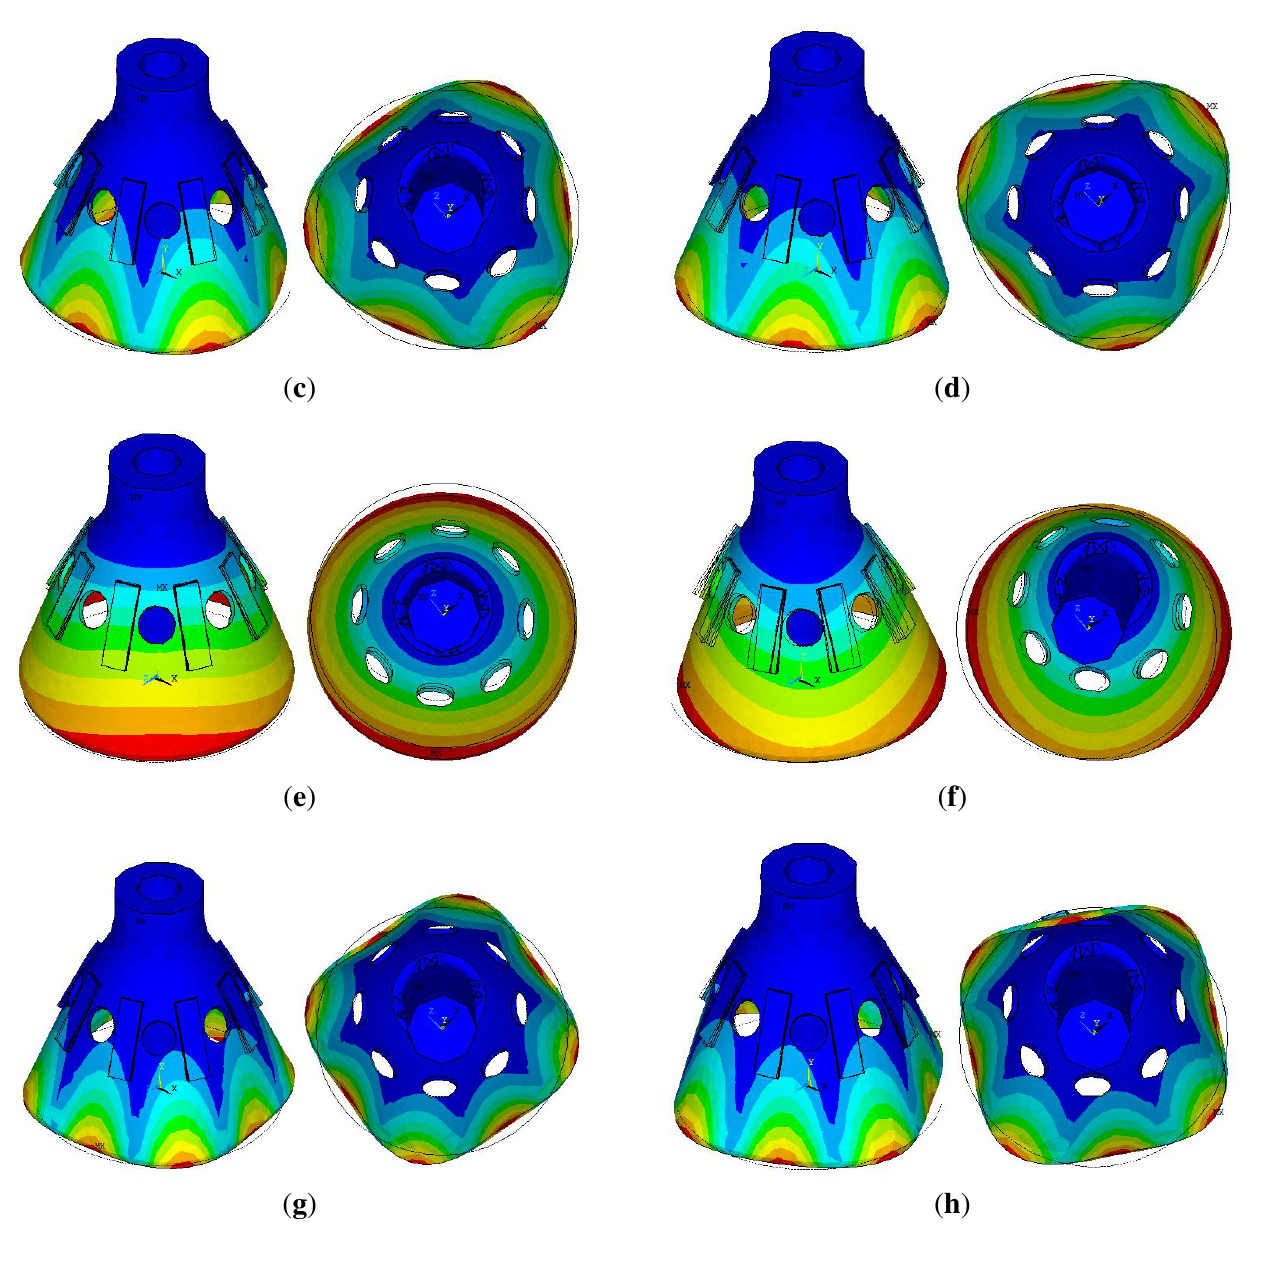
Table 2. The parameters with